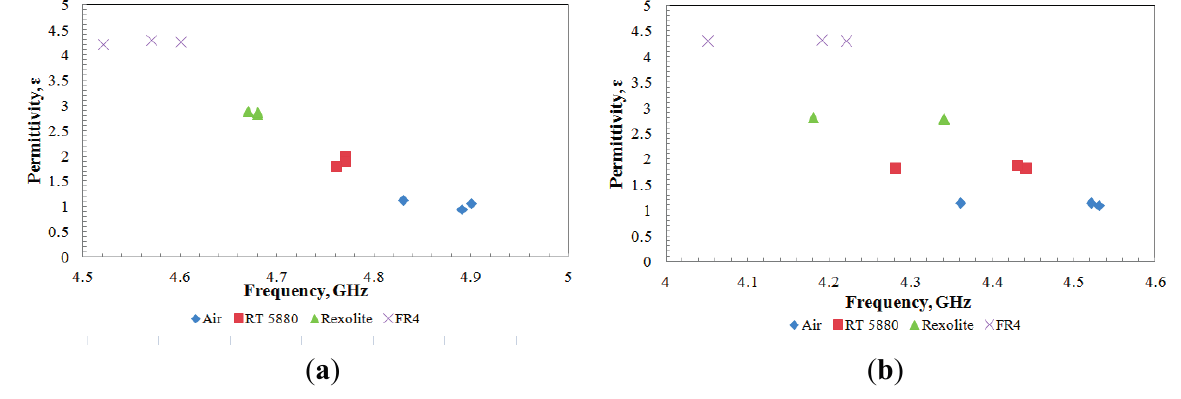
Figure 12. Sensor measurement for three types of sensor for ( a ) aligned-gap multi-ring; ( b ) centered-gap